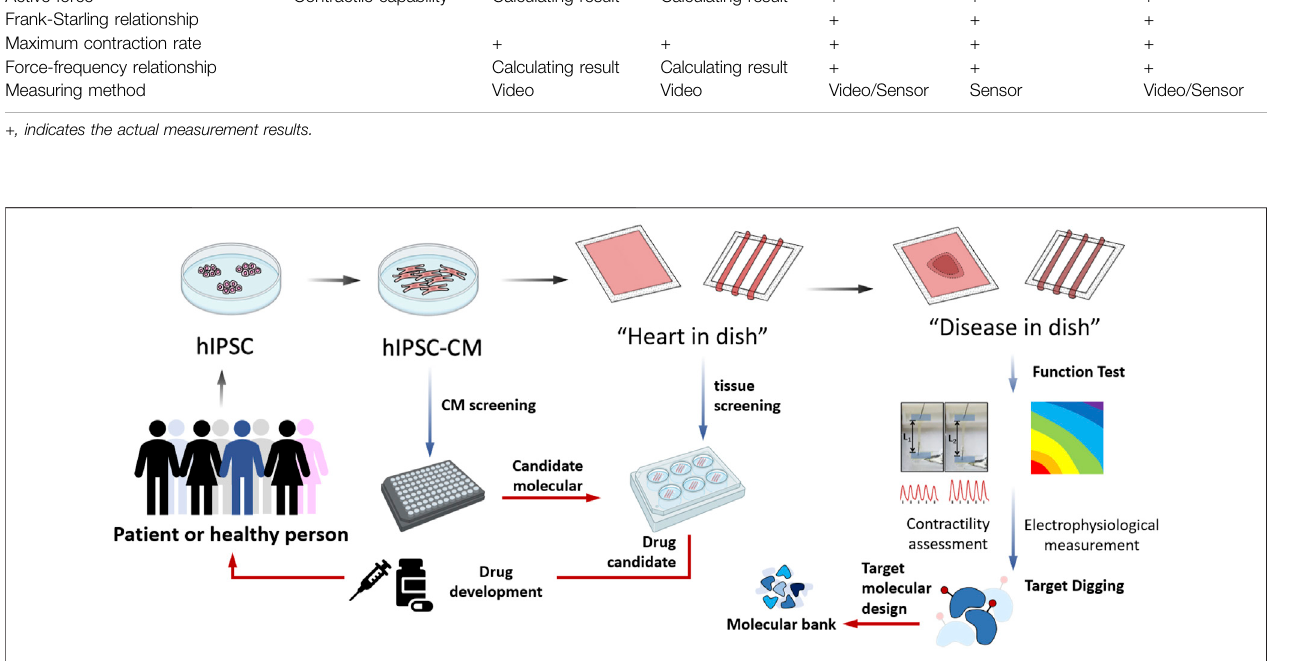
FIGURE 1 | The applications of hIPSC derived cardiomyocytes assembled engineering heart tissue model in cardiovascular